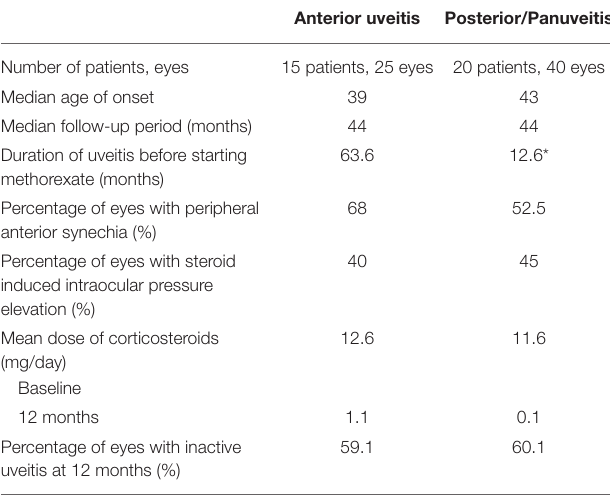
TABLE 3 | Treatment outcomes of patients with anterior uveitis and posterior/panuveitis treated with methotrexate. Anterior uveitis Posterior/Panuveitis Number of patients,